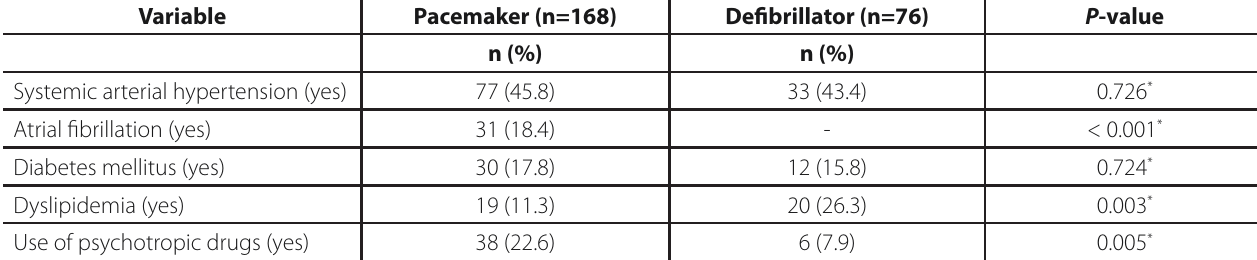
Table 2 . Clinical characterization of the 244 participants according to the type of device (implantable cardiac pacemaker and implantable cardioverter defibrillator). Ribeirão Preto, 2019.